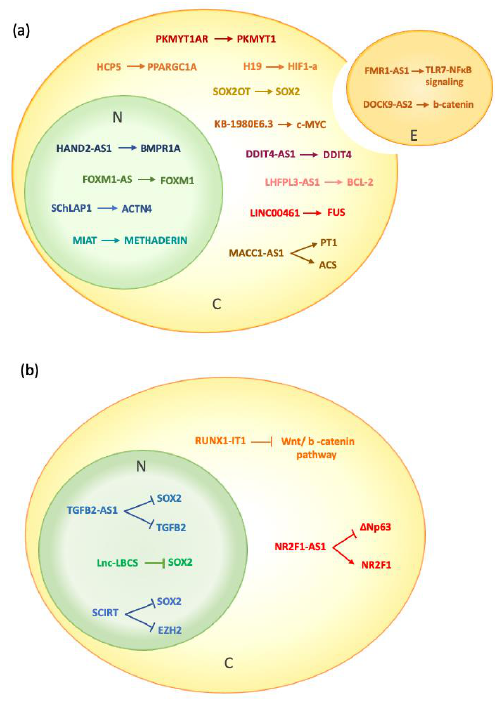
Figure 1. Schematic representation of lncRNAs localization and targets ( a ) lncRNAs that increase self-renewal and maintenance of CSCs. ( b ) lncRNAs counteracting the stemness of CSCs. N: nucleus; C: cytoplasm; E: exosome.